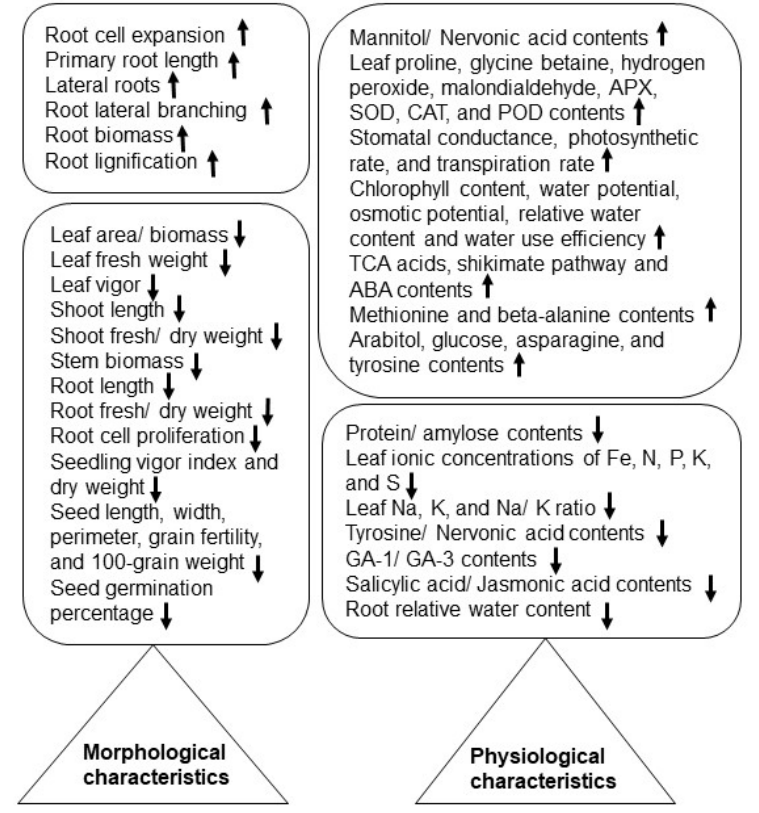
Figure 1. Morphological and physiological changes reported under salt stress in crops. Upward and downward arrows show an increase and decrease, respectively, in morphological or physiological characteristics.